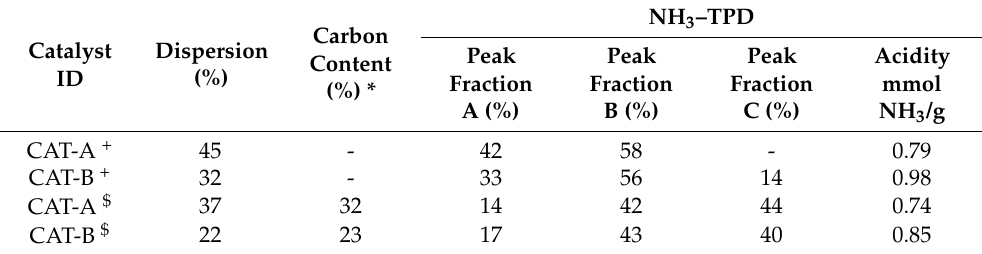
Figure 2. Ammonia TPD profiles of CAT-A before ( a ) and after ( b ) the dehydrogenation reaction. Table 2. Physico-chemical properties of catalysts before and after dehydrogenation of H18-DBT, including the quantity of carbon